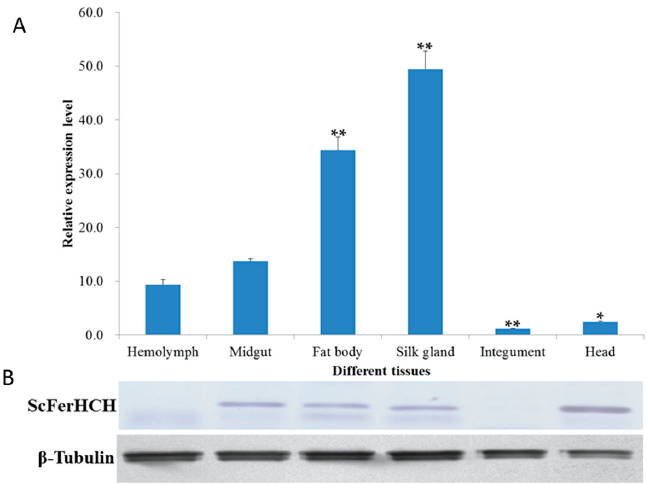
Figure 4. Expression profiles of ScFerHCH in different tissues of the fifth instar larvae of S. c. ricini . ( A ) The mRNA levels of ScFerHCH as measured by RT-qPCR. Data were normalized using S. c. ricini β -actin and are represented as the means ± standard errors of the means from three independent experiments. Relative expression levels were calculated using the 2 −∆∆ C t method. Statistical analysis was performed using SPSS software. The significant differences are indicated by * ( p < 0.05) or ** ( p < 0.01); ( B ) Western blot analysis of ScFerHCH proteins in different tissues of S. c. ricini using β -tubulin used as an internal reference.